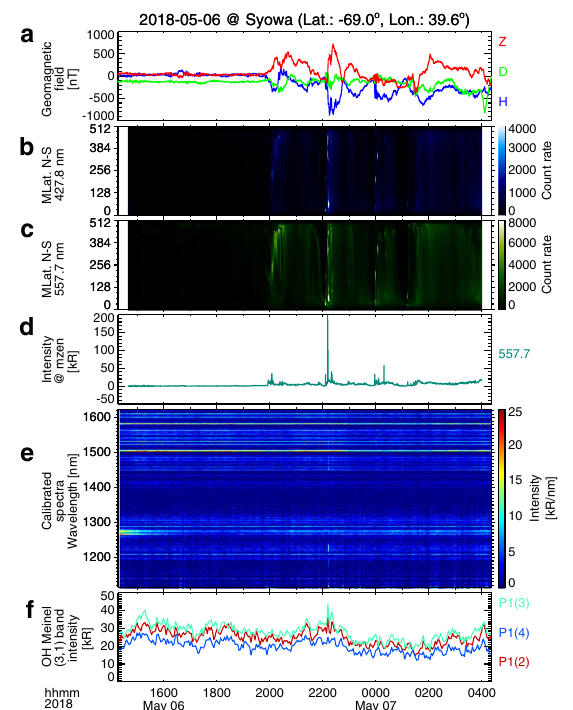
Fig. 5 NIRAS measurements with the 150-lpmm grating on May 6, 2018 and comparisons to observed aurora activity. a Geomagnetic field variations in H, D, and Z components ( b ) and c Aurora keograms along magnetic latitudinal directions obtained from all-sky aurora imagers for N + 2 427.8 nm and O 557.7 nm, respectively d Aurora intensity of O 557.7 nm emission at magnetic zenith as a function of time. e Dynamic spectrum from 1114 to 1624 nm obtained by function of